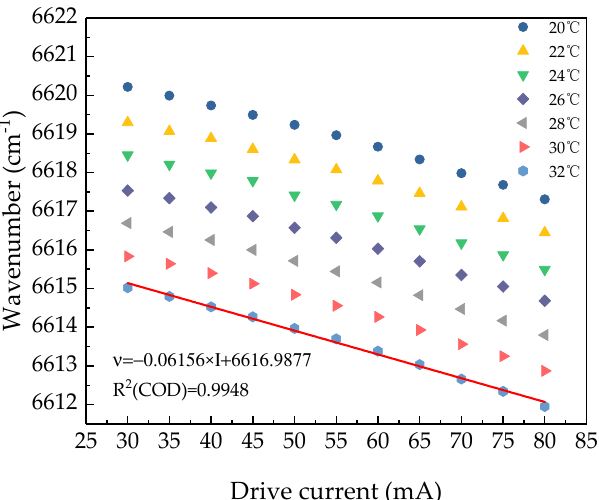
Figure 1. ( a ) Absorption spectra of NH 3 , H 2 O, CO 2 from 6550 cm − 1 to 6650 cm − 1 . ( b ) Absorption spectra of NH 3 (1000 ppm·m, blue line), H 2 O (1%, red line), and CO 2 (0.03%, yellow line) at an optical path of 60 m based on HITRAN database and the plot of drive current versus wavenumber of the distributed feedback (DFB) laser (black line), the value of modulation current at the central wavenumber 6612.7 cm − 1 is 69.48 mA.